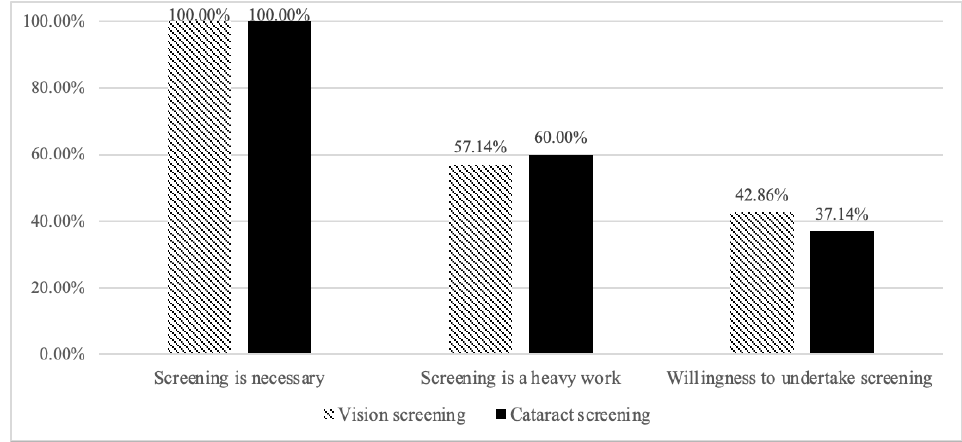
Figure 2. Village doctors’ willingness and attitude towards providing services for vision or cataract screening (N = 35), Percentage (%).